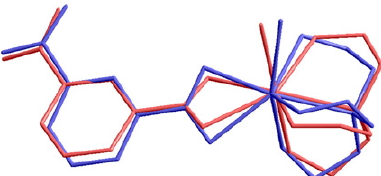
Figure 5. Superimposition of X-ray(red) and optimized(blue) ge- ometries of [Cd(IsoPht)(TEA)H 2 O]·3H 2 O Table 3. Hydrogen bond interactions for [Cd(IsoPht)(TEA)